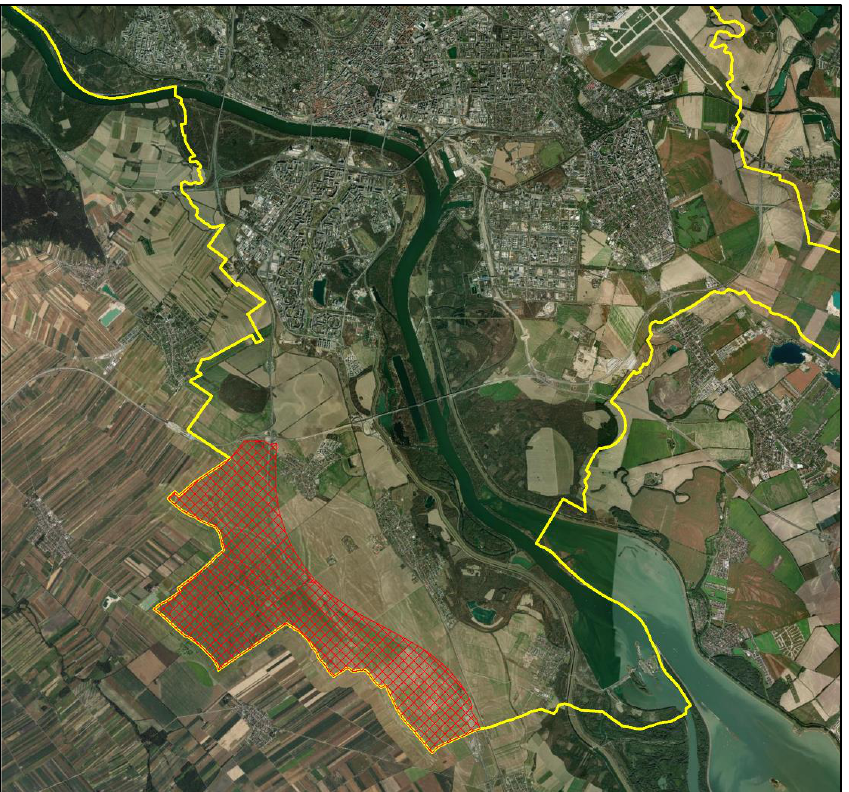
Figure 6. Special Protection Area Sysľovské polia (© NLC, Zvolen, GKÚ , Bratislava, Slovakia, Ortophotomosaic).